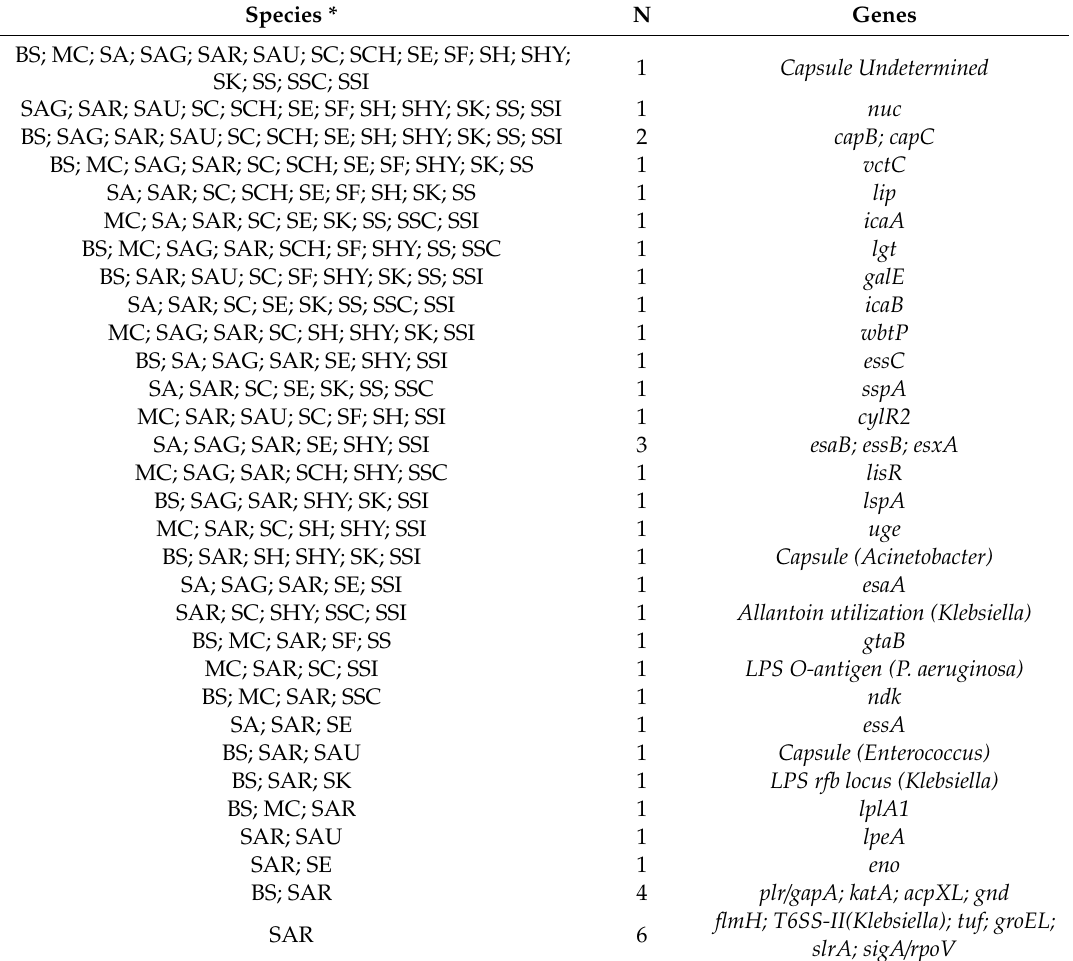
Table 5. Genes encoding virulence factors shared between SAR and other species in the